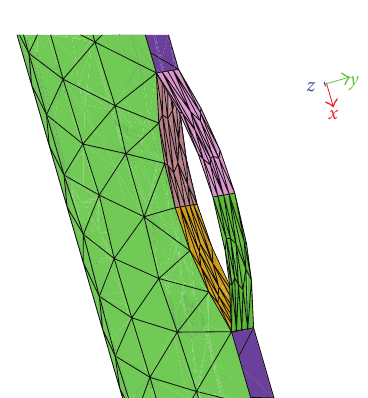
Figure 7: Detail of the blade from above with half-wall channel